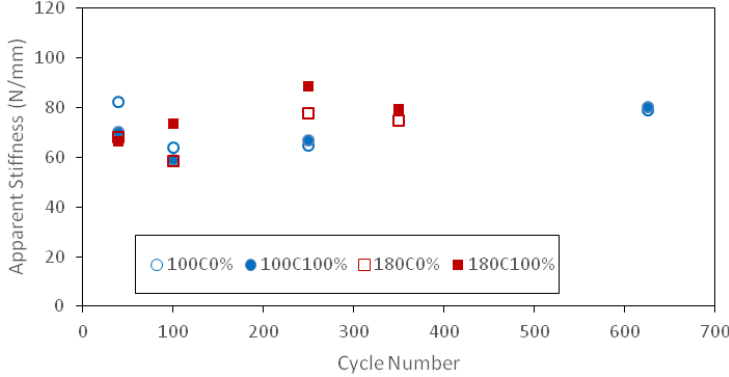
Figure 17. Apparent stiffness vs. number of cycles at 100 ◦ C and 180 ◦ C (Cp = 2, 0%